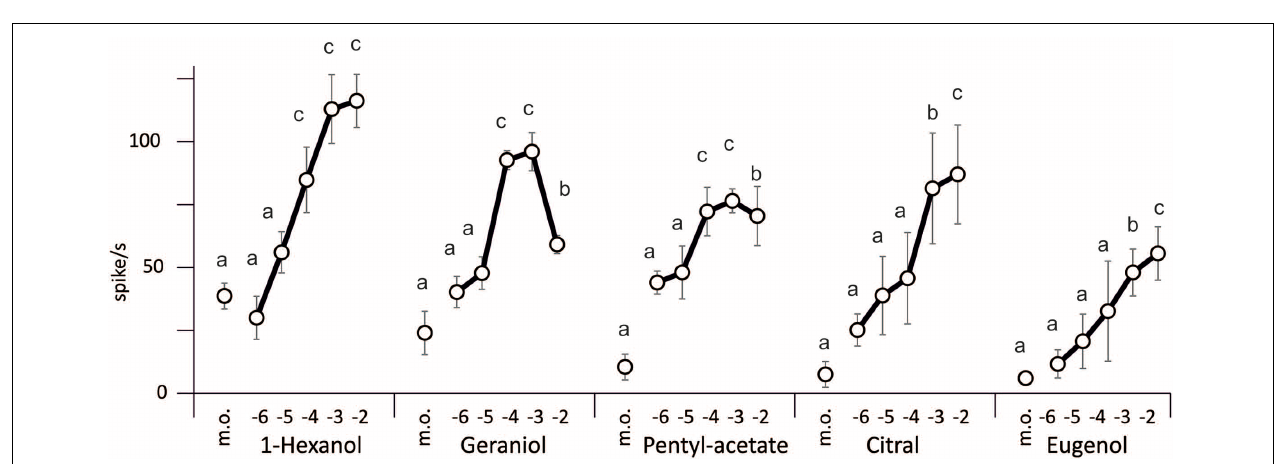
FIGURE 4 | Electrophysiological responses of the sensillum B2–5 odorants in relation to the dose. Odorants were delivered to the antenna during 500ms. The concentration of each odorant was expressed in log 10 of moles (M) (m.o, mineral oil). Each data point of the graph represents the average firing rate ( ± s.e.m.) calculated from